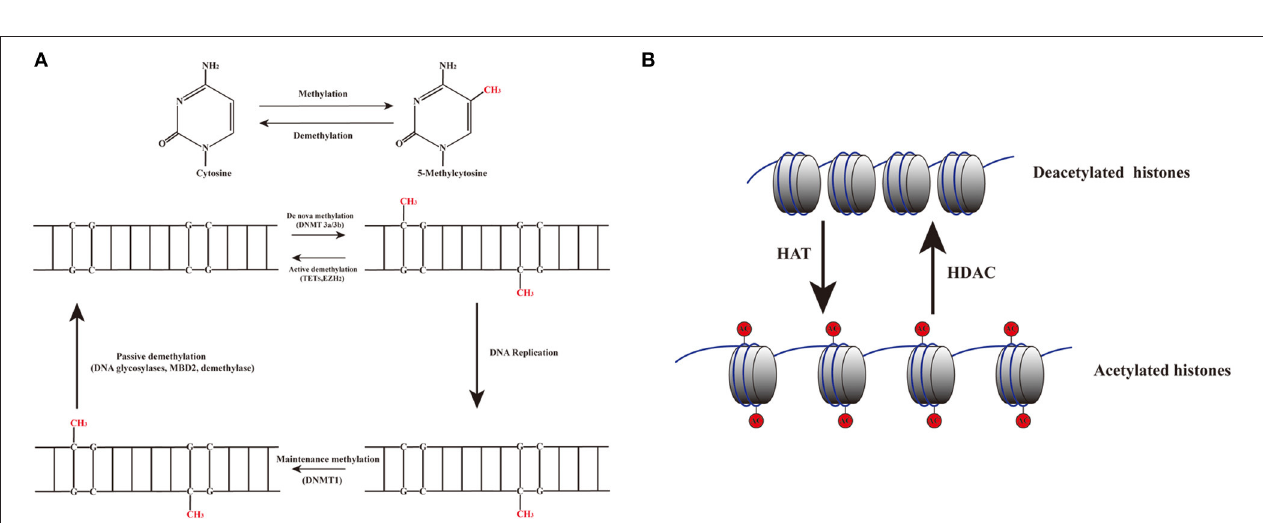
FIGURE 3 | Dynamic mechanisms of DNA methylation and demethylation. (A) The addition of a methyl group to the 5th carbon in cytosine residues of cytosine-guanine (CpG) dinucleotides produces 5-methylcytosine residues. DNMT3a and DNMT3b are involved in de novo methylation; DNMT1 maintains epigenetic covalent modifications during DNA replication. DNA demethylation can be aroused actively or passively. Passive demethylation is induced by the failure of maintenance methylation after DNA replication. Active methylation is caused by replication-independent processes. (B) Histone acetylation is dynamically catalyzed by HATs by transferring acetyl groups to lysine, which leads to an open conformation of chromatin permitting gene expression. Deacetylation is implicated in repressing gene expression by HDACs via removing the acetyl